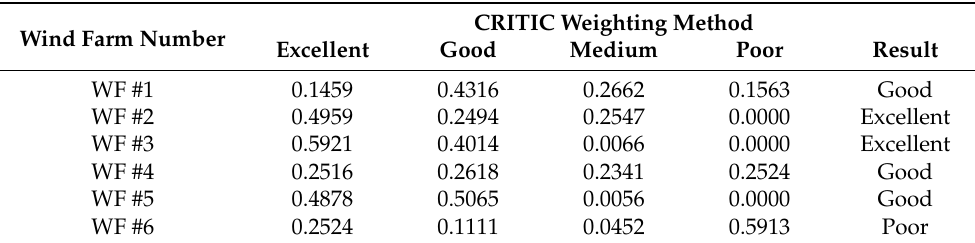
Table 10. The comprehensive evaluation results of wind farms power generation performance (CRITIC weighting method).